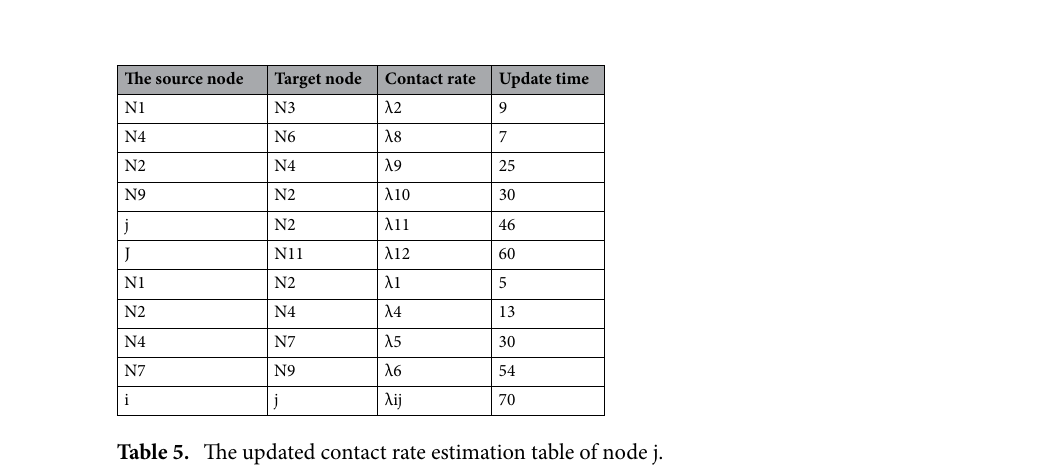
Table 5. The updated contact rate estimation table of node j.